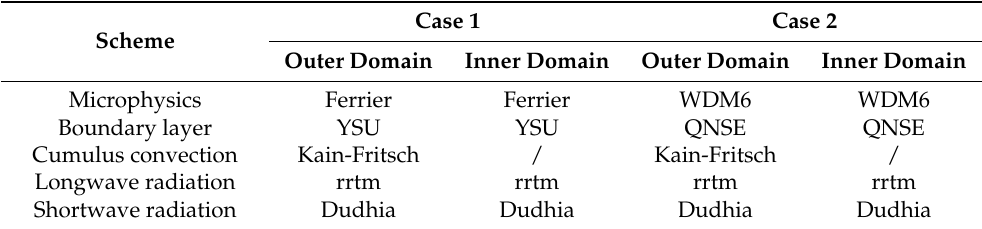
Table 1. Model parameter configuration of control experiments.